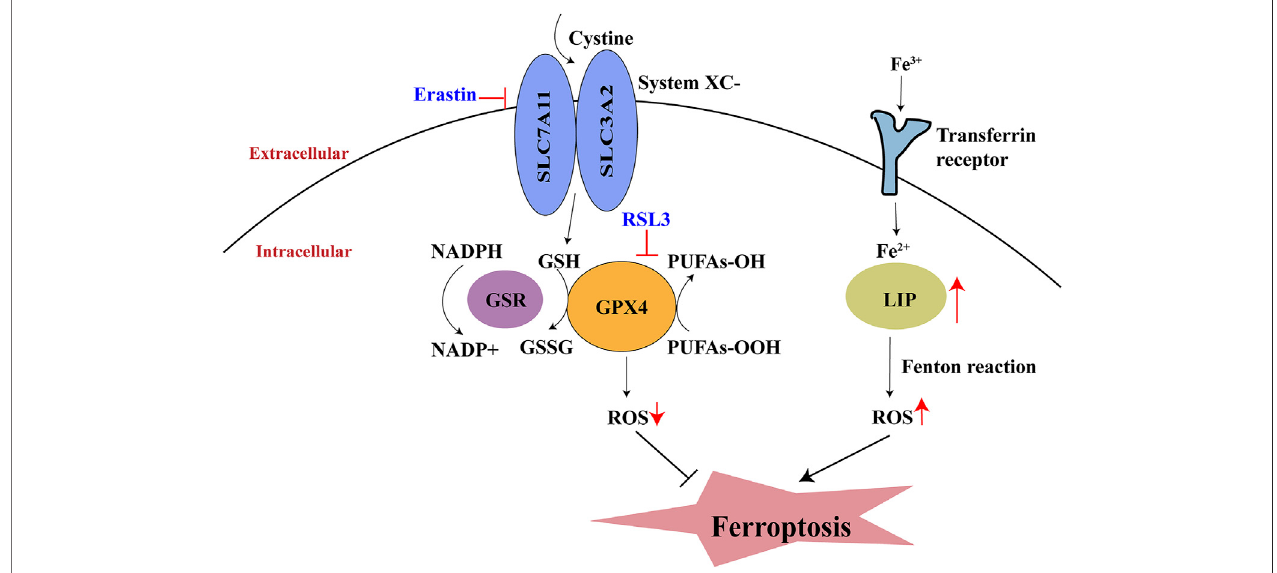
FIGURE 1 | Process of ferroptosis. System Xc-, cystine/glutamate antiporter system; GSH, glutathione; GPX4, glutathione peroxidase; GSSG, oxidative glutathione; LIP, labile iron pool; NADPH, Nicotinamide adenine dinucleotide phosphate; PUFA, polyunsaturated fatty acid.